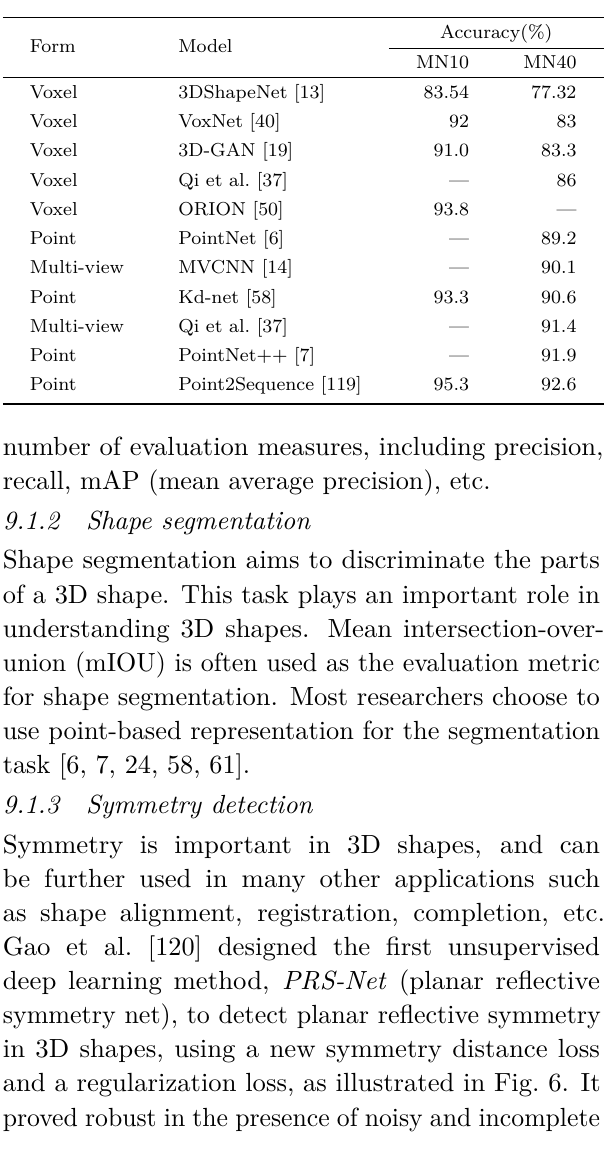
Table 2 Accuracy of shape classification methods on ModelNet10 and ModelNet40 datasets